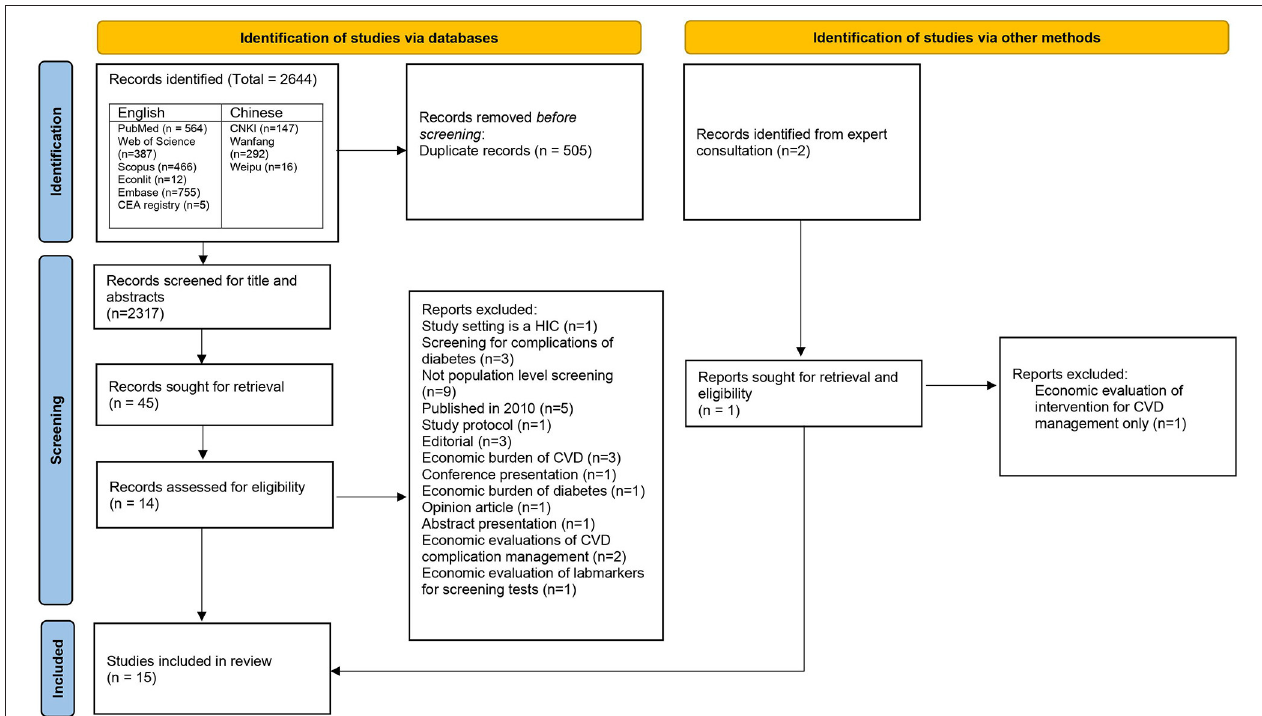
FIGURE 1 | PRISMA